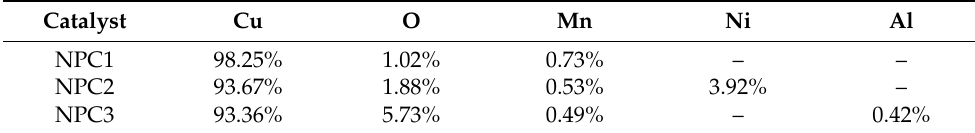
Table 1. EDS data of nanoporous copper